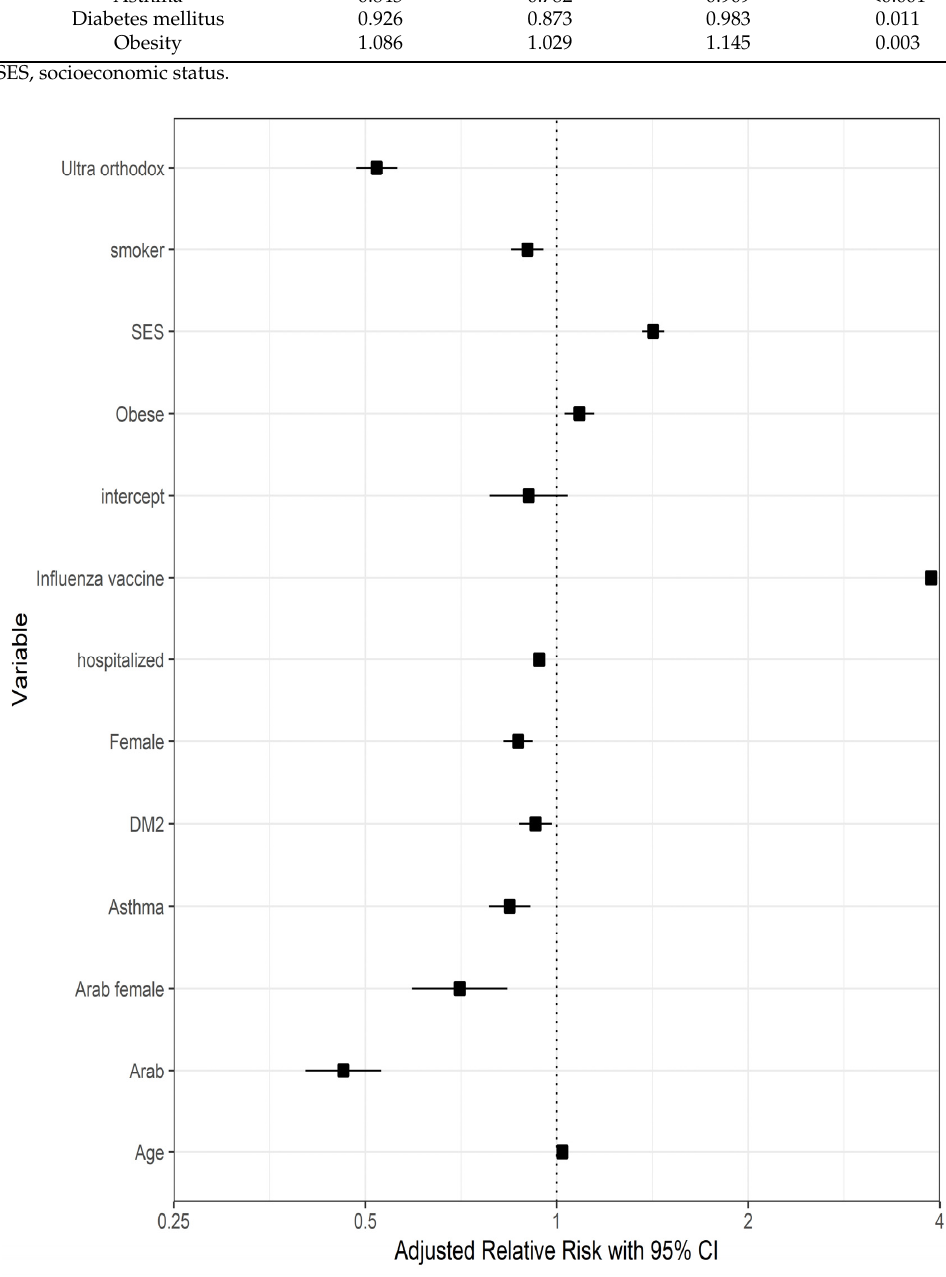
Figure 2. Forest plot describing the adjusted relative risks of various variables on vaccine ac-